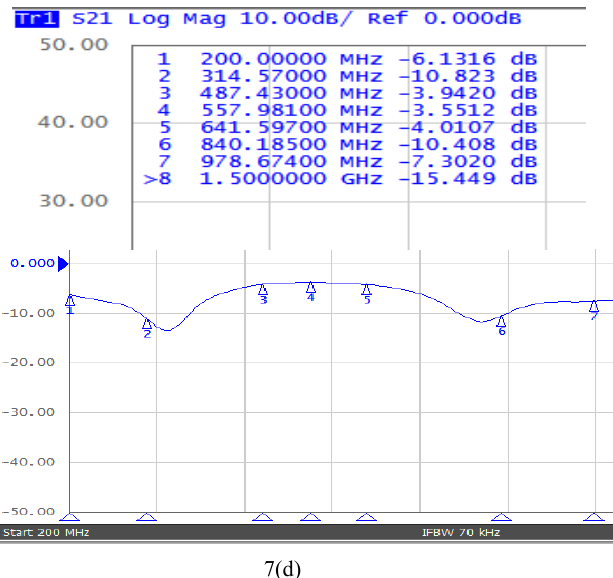
Fig. 7: Measured S- Parameters of the proposed 3 dB